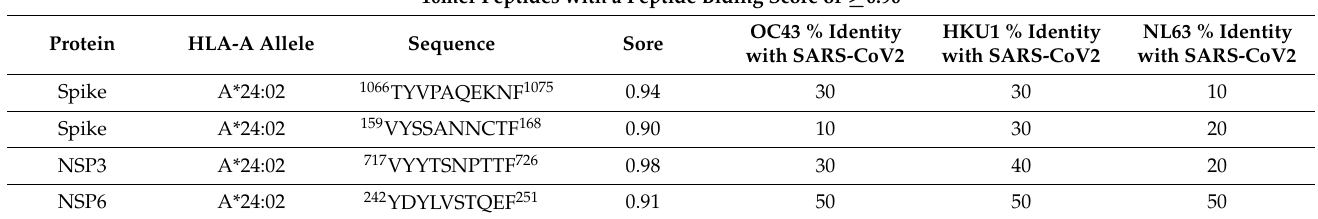
Table 1. Cont. 10mer Peptides with a Peptide Biding Score of ≥ 0.90